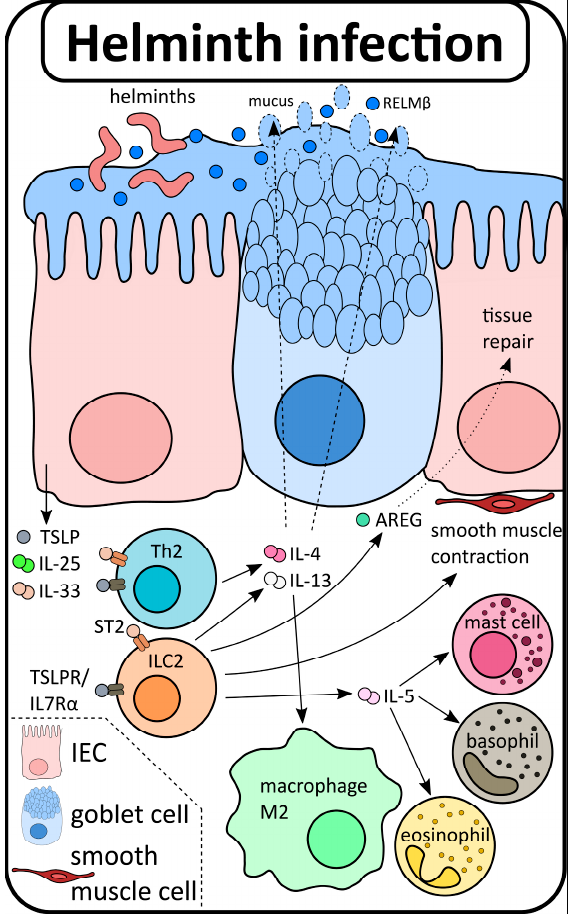
Figure 1. Type 2 immunity during helminth infection. Release of alarmins from IECs during helminth infection triggers the production of type 2 cytokines from Th2 and ILC2 cells, inducing smooth muscle contraction, tissue repair, immune cell recruitment, mucus and RELM β production in order to expel the worms. AREG, amphiregulin; IEC, intestinal epithelial cell; IL, interleukin; ILC, innate lymphoid cell; RELM β , resistin-like molecule-beta; Th, T helper cell; TSLP, thymic stromal lymphopoietin